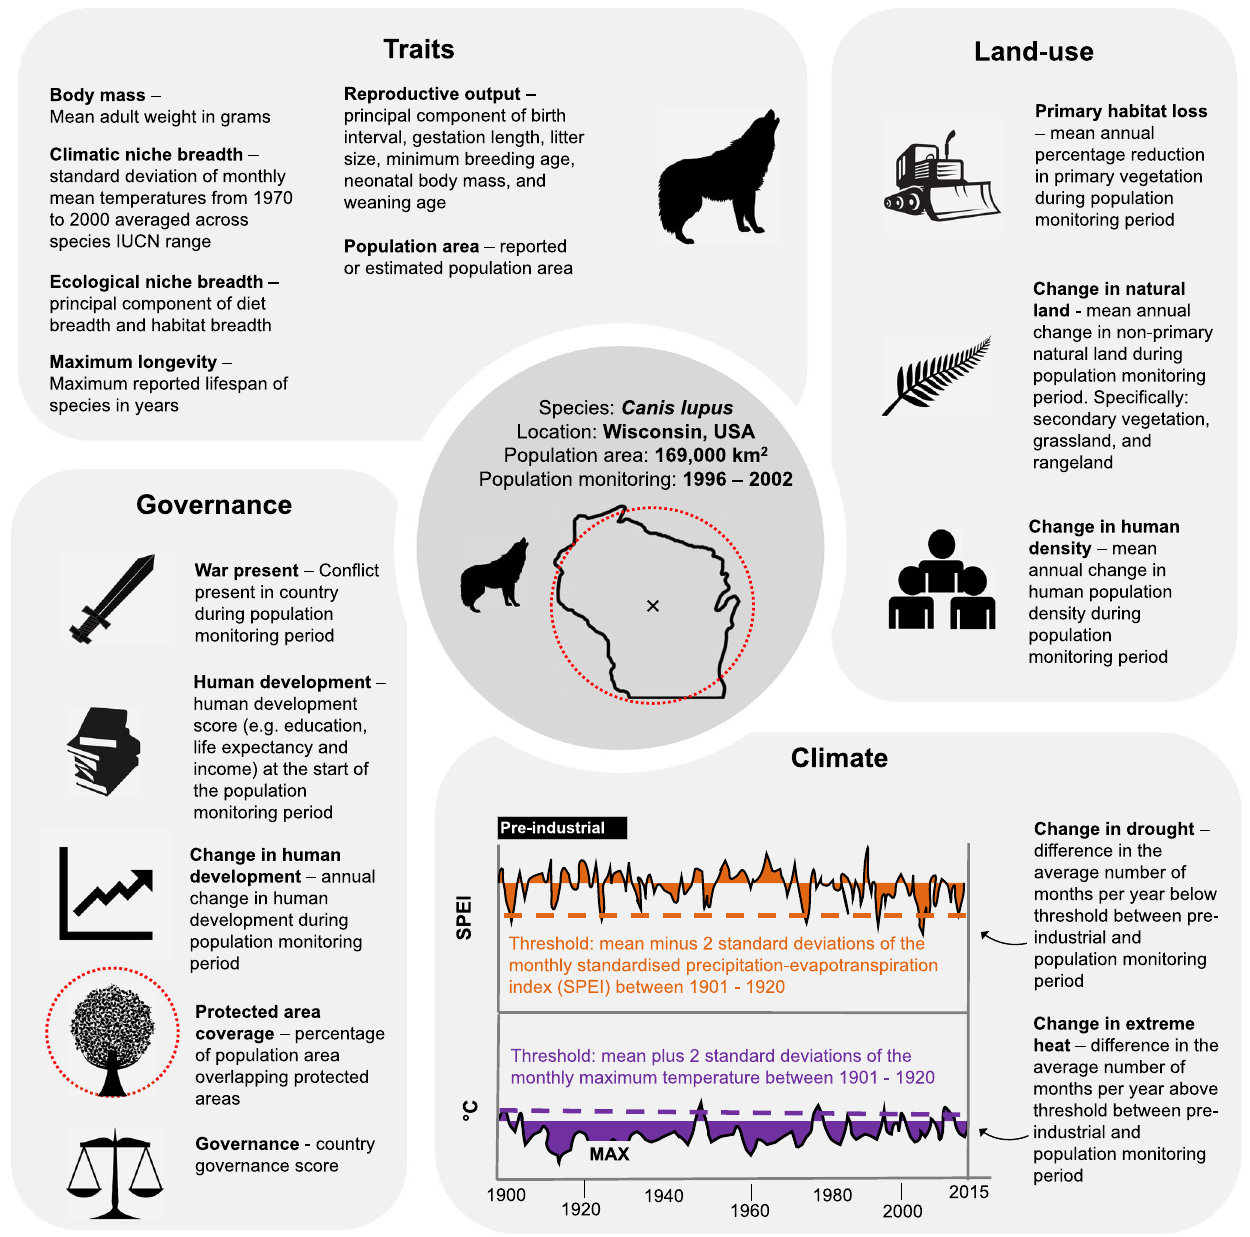
Fig. 2 | Sixteen covariates with a proposed effect on carnivore population trends. Covariatesare highlightedin boldand fall in four groups: Traits, Land-use, Climate, and Governance. Text alongside covariates brie fl y explains how the